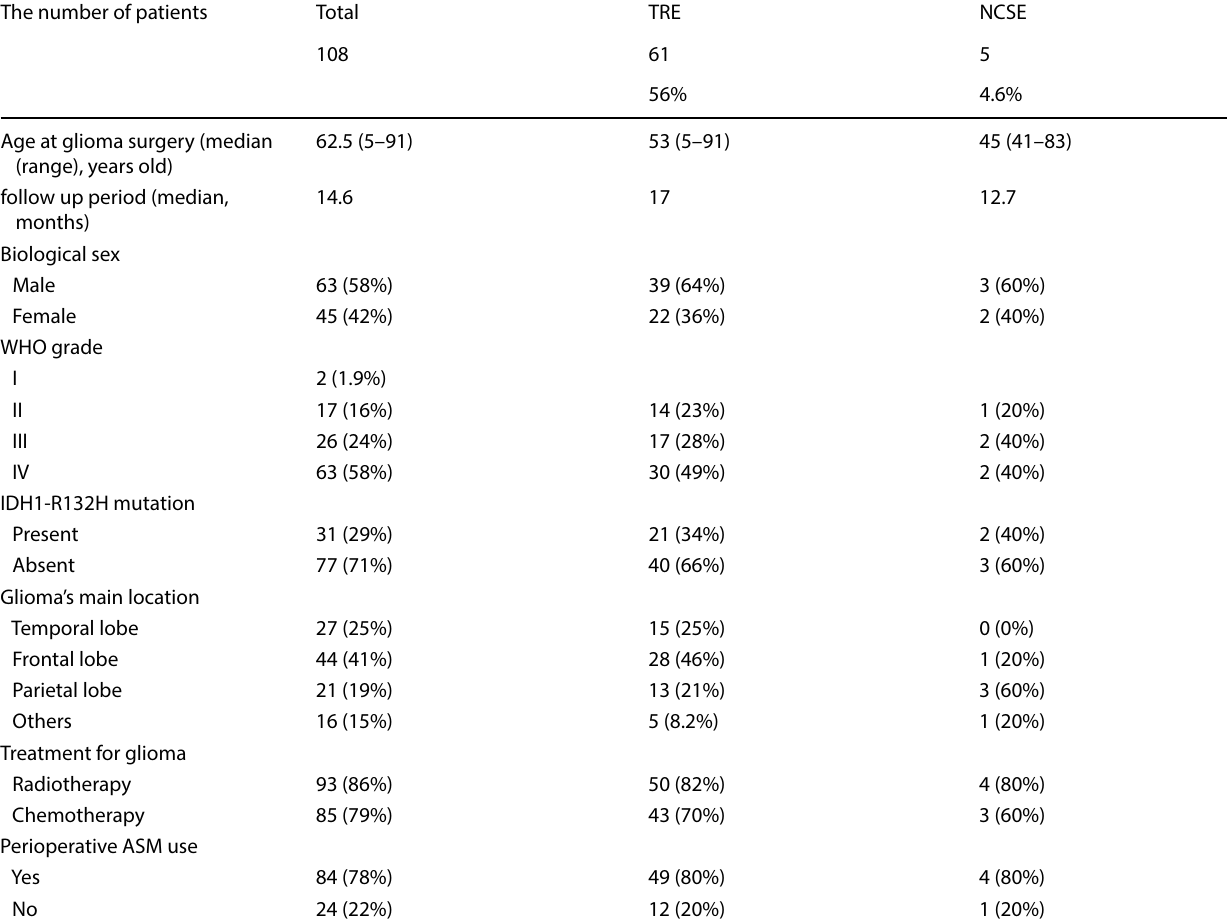
Table 1 Glioma patient